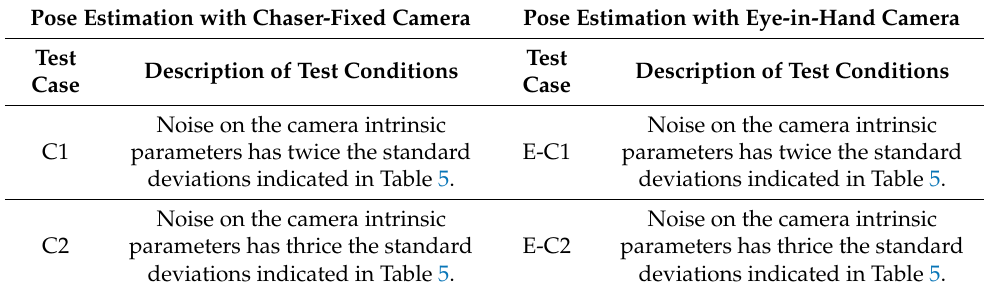
Table 9. Summary of test cases with variable accuracy on the knowledge of the camera intrinsic parameters for both the pose estimation with the chaser-fixed and the eye-in-hand cameras.